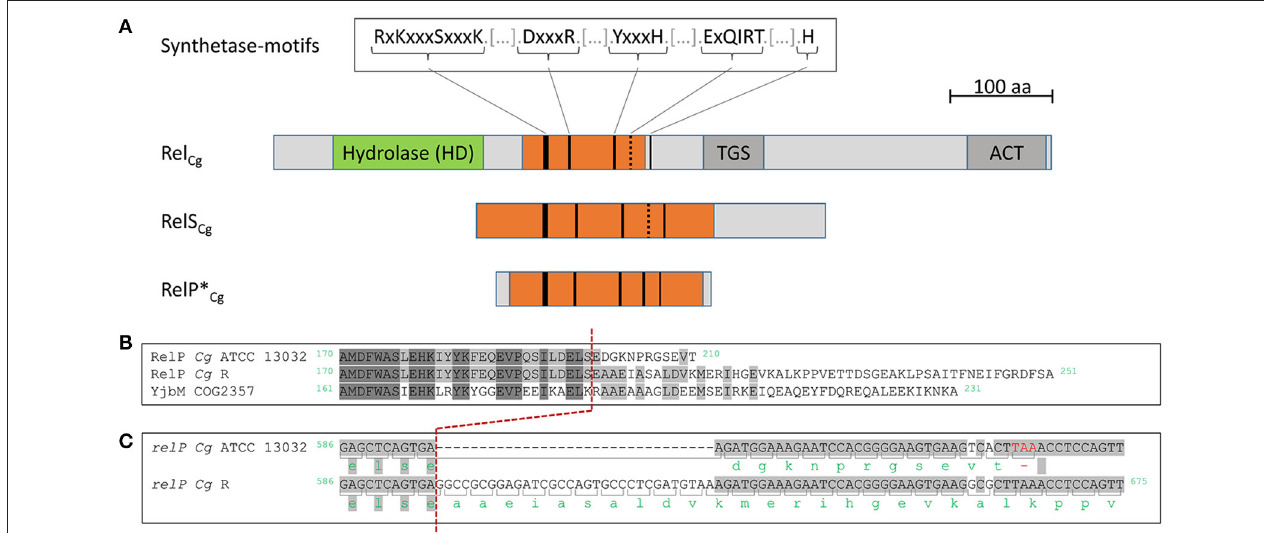
FIGURE 1 | C. glutamicum enzymes involved in (p)ppGpp synthesis. (A) True-to-scale representation of domain architecture and conserved sequence motives of stringent control-associated enzymes of C. glutamicum ATCC 13032. Hydrolase domain (pfam01966) and ppGpp synthetase catalytic domain YjbM (COG2357) are indicated in green and orange, respectively. Matches with conserved synthetase motifs are represented by black lines (Bag et al., 2014; Steinchen and Bange, 2016). Minor deviations from the conserved sequence motifs are shown by dashed black lines. (B) Sequence alignment of the C-termini of RelP variants from C. glutamicum ATCC 13032 ( Cg ATCC13032) and C. glutamicum R ( Cg R) with the synthetase catalytic domain consensus sequence YjbM (COG2357). Identical residues among all three sequences are indicated by dark shading and matches between two sequences by light shading, respectively. Amino acid positions are shown at both sequence ends. (C) Alignment of the nucleotide sequences of the relP variants from C. glutamicum ATCC 13032 and C. glutamicum R. Codons and the corresponding amino acid residues are indicated below the nucleotide sequences with stop codons highlighted in red. Nucleotide positions are shown at both sequence ends. Since the relP sequence of C. glutamicum ATCC 13032 ends before the end of the alignment, no positional information can be given. Matches between the nucleotide and protein sequences are represented by gray shadings. The relationship between the nucleotide sequences and the corresponding amino acid sequences is illustrated by a dashed red